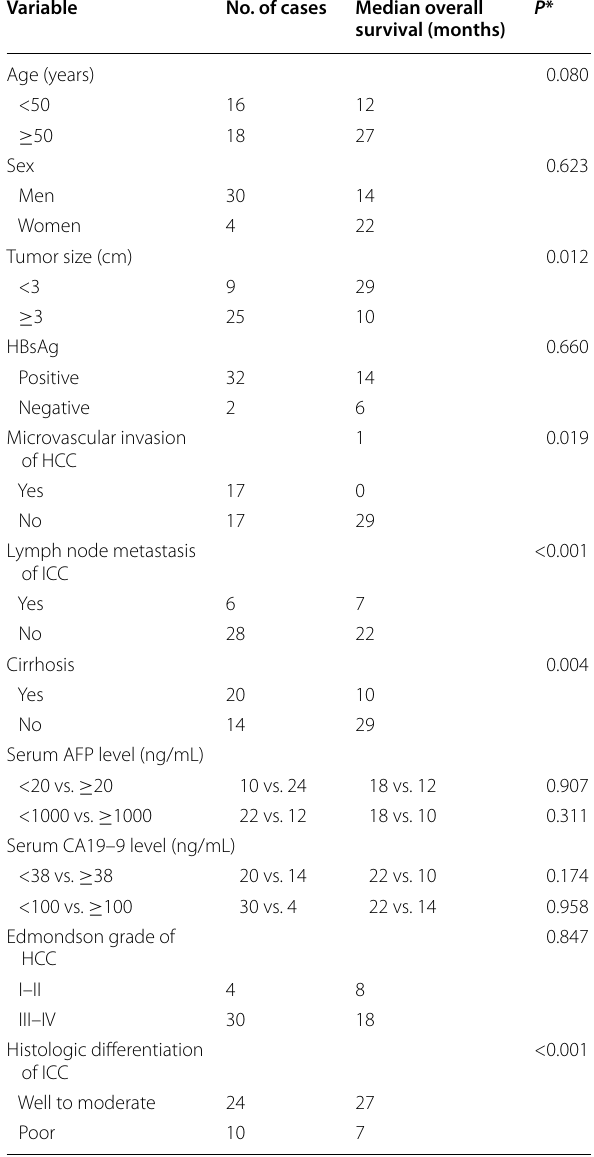
Table 5 Univariate analysis of factors related to survival of patients with